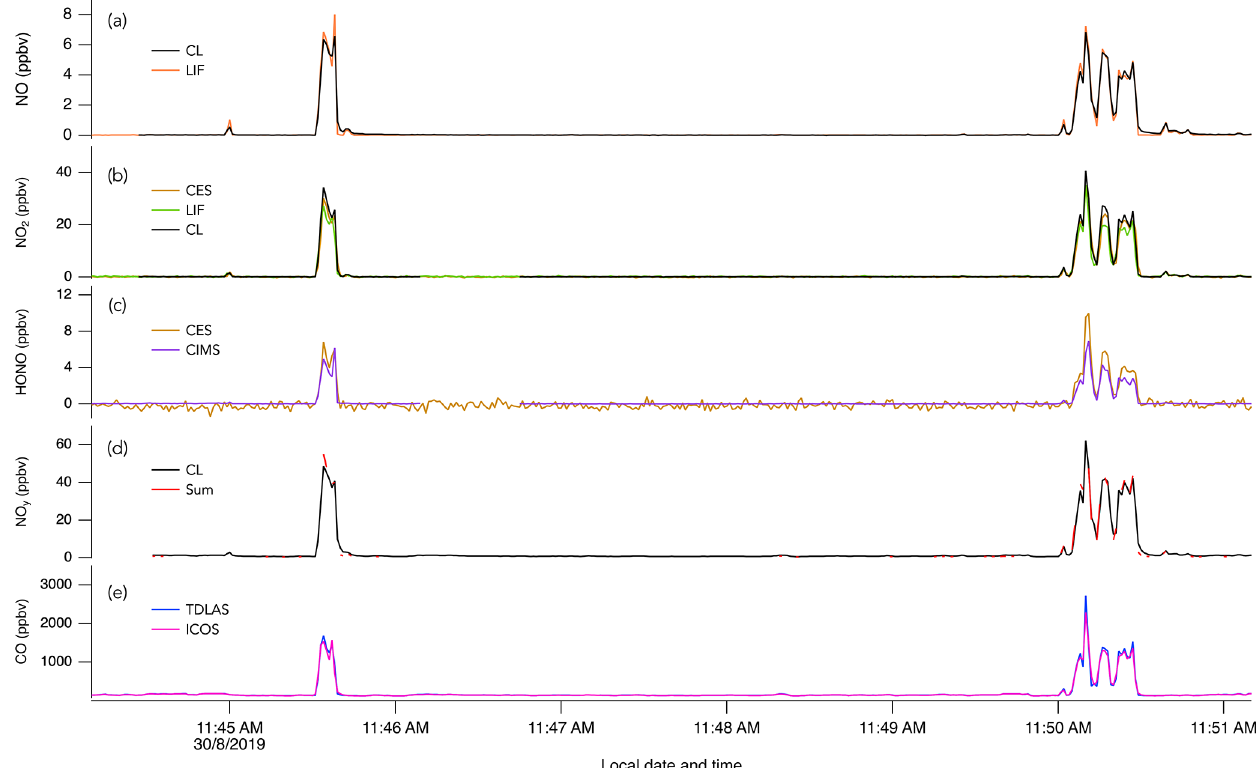
Figure 4. The 1s measurements of (a) NO, (b) NO 2 , (c) HONO, (d) NO y , and (e) CO during crosswind plume transects of smoke from crop burning in southeastern US on 30 August